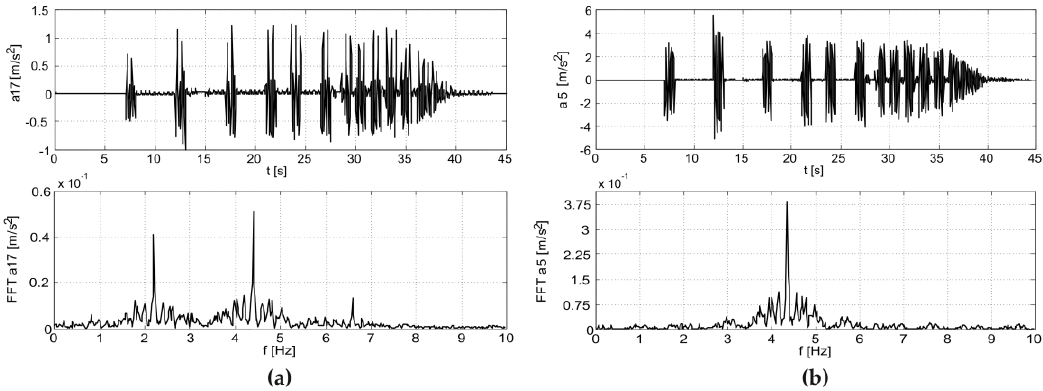
Figure 20. Results of numerical simulations from the excitation of vibrations by jumping fans (Scotland-type jumps): ( a ) girder, ( b ) roof.